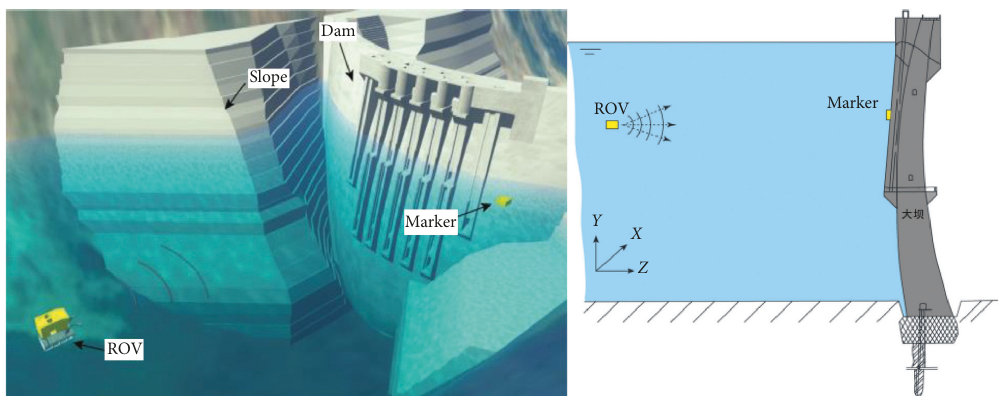
Figure 1: Schematic diagram of plane wave propagation in reservoir environment